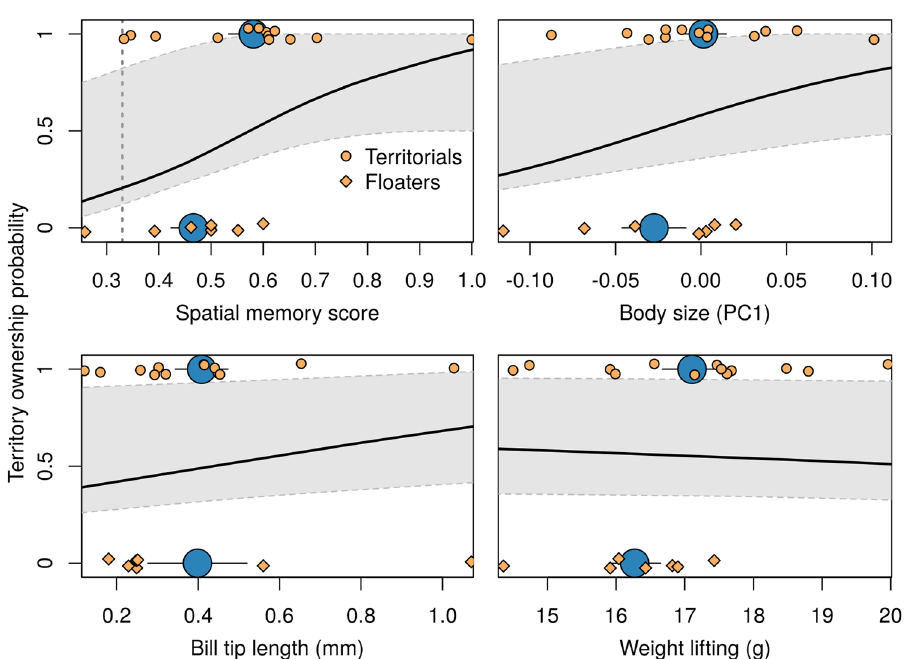
Figure 2. Predicted probability of territory ownership (black line) for four phenotypic traits from adult male long-billed hermits. Observed values for territorial and floater males are shown by orange circles and diamonds, respectively and the average ( + / − S.E.) values are shown in blue. The 95% confidence intervals of the probabilities are shown in gray. Body size was calculated as the first principal component from a PCA on three morphological traits: body mass, total culmen, flattened wing length and central rectrice length. The vertical dotted line on the spatial memory graph shows the spatial memory performance expected by chance (e.g. if memory is not